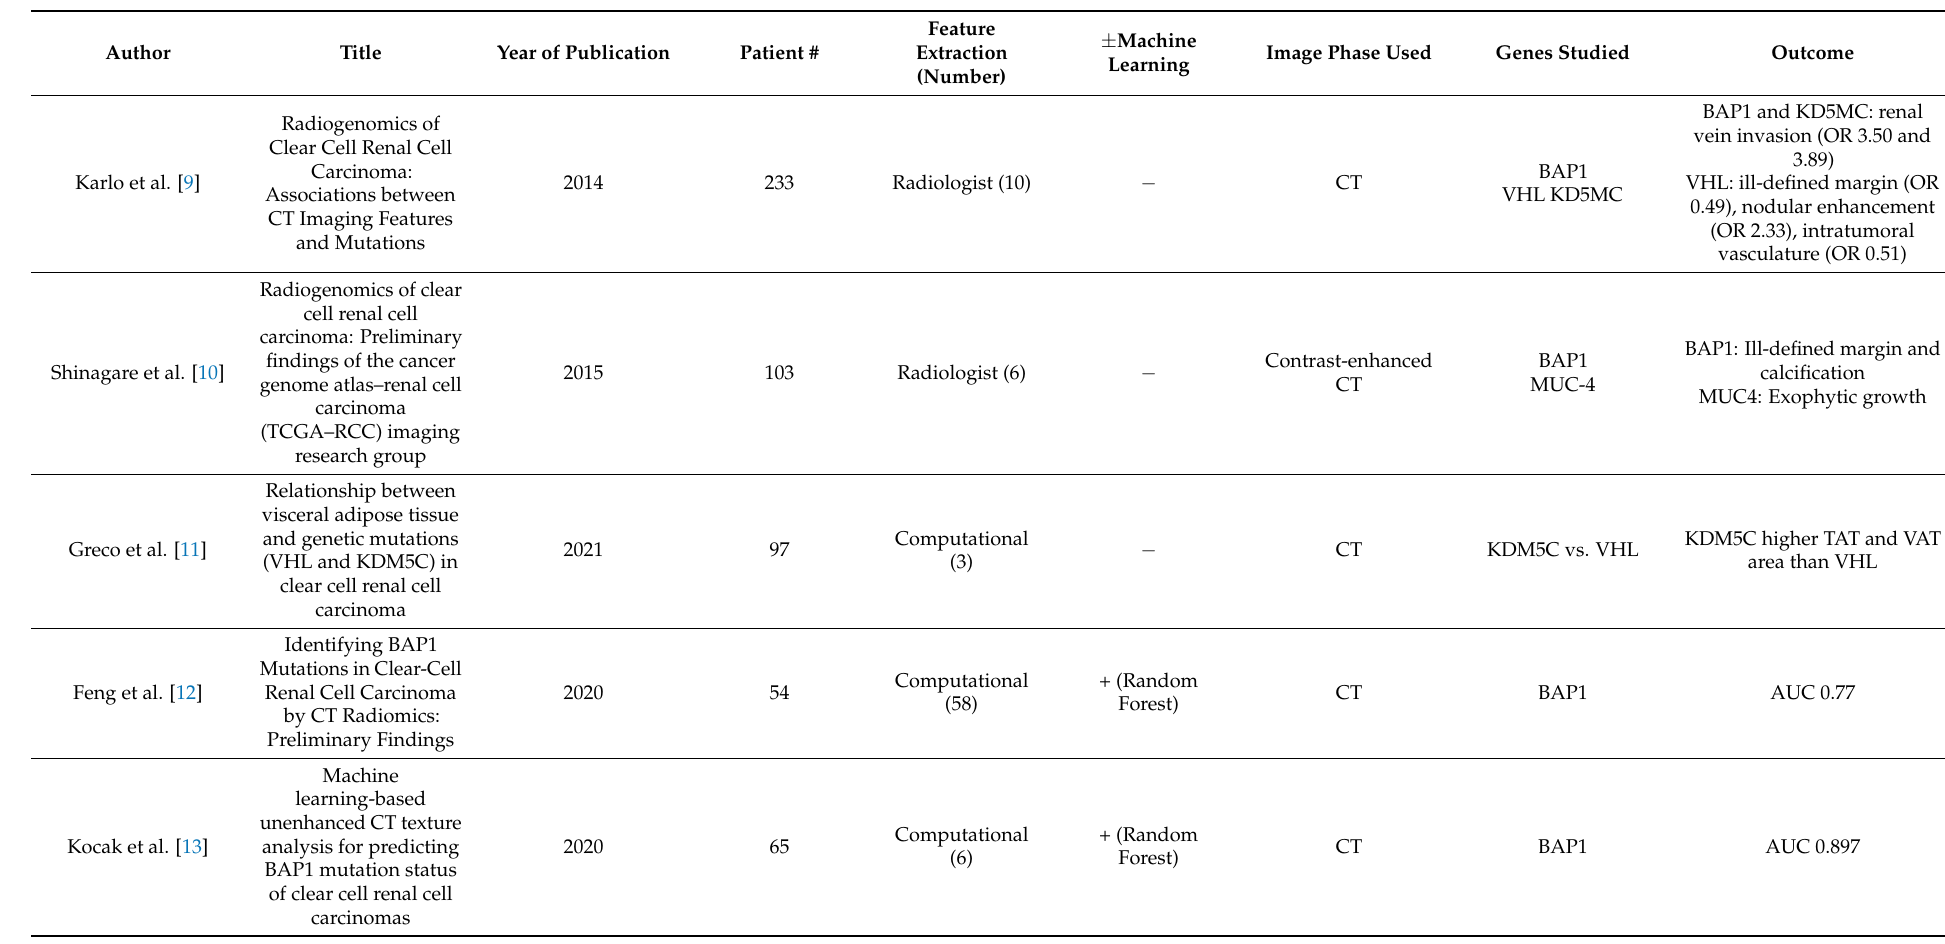
Table 1. Summary of 20 reviewed articles on radiogenomics in clear cell renal cell carcinoma. Nature of feature extraction is indicated by “Radiologist” if features are scored by one or more radiologists. Elsewise, software derived features are indicated by “Computational”. Number of selected features indicated in parenthesis. TAT (total adipose tissue), VAT (visceral adipose tissue), AUC (area under the curve), OR (odds ratio), HR (hazard ratio), CSS (cancer specific survival), OS (overall survival), PFS (progression free